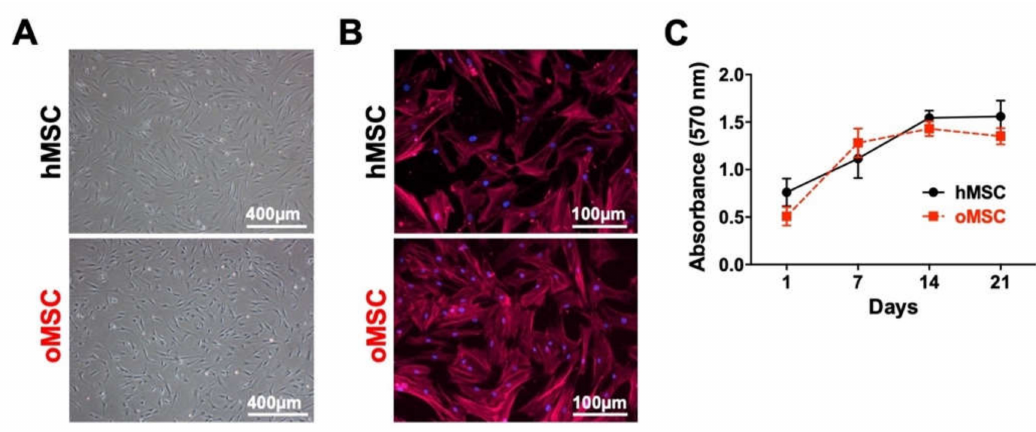
Figure 1. Mesenchymal bone marrow-derived stromal cells (BMSC) from vertebral bodies’ bone marrow of osteoporotic donors (oMSC) and healthy control donors (hMSC) showed comparable growth behavior and morphology. ( A ) BMSCs from both groups showed typical fibroblastic morphology and comparable size at passage 1. ( B ) BMSCs at passage 3 were cultured as a monolayer and stained for cytoskeleton-actin (red) and nuclei (blue). ( C ) Growth behavior of BMSCs from both groups was assessed using MTT assay through absorbance measurement (570 nm) at indicated time points. Data are expressed as average ± SD of 5 donors per